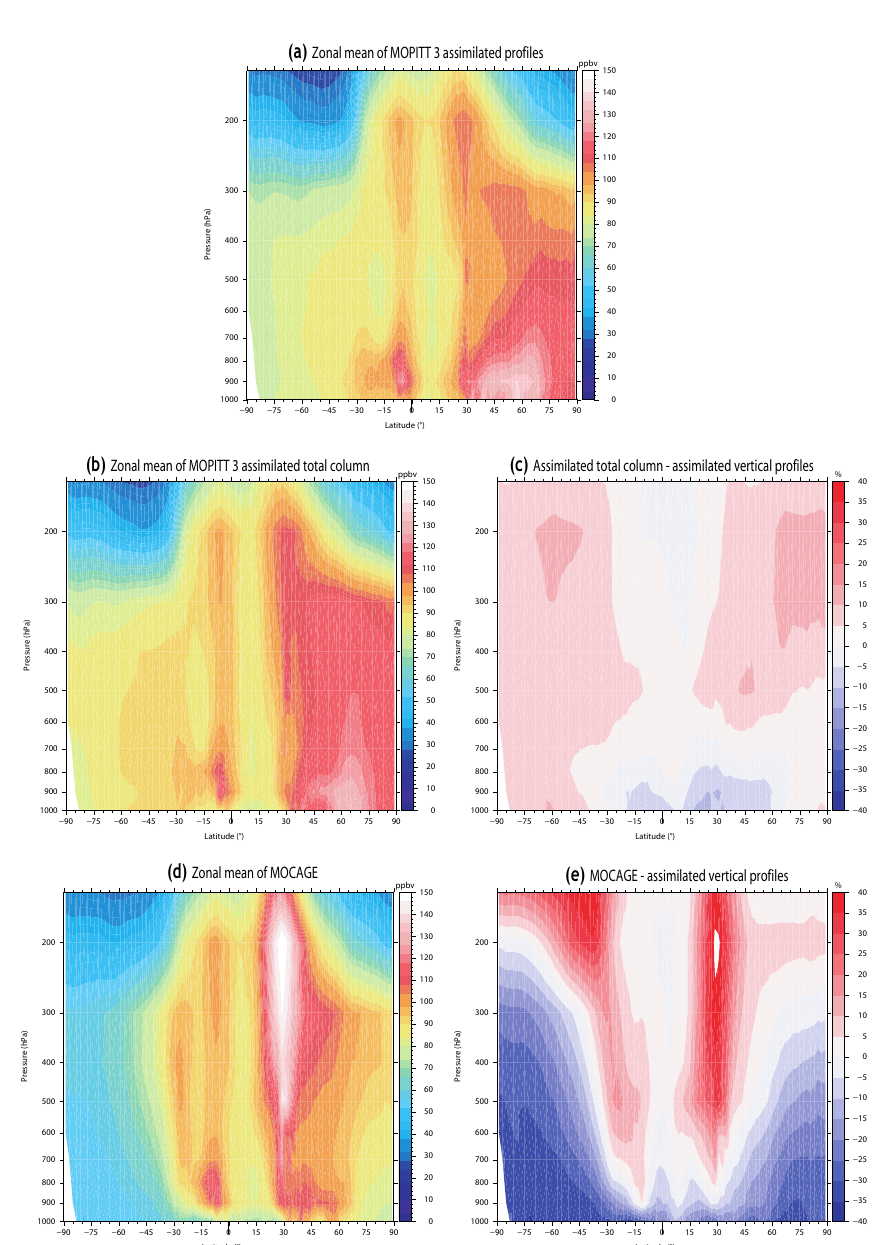
Figure 12. Zonal means of CO field for the month of August 2008 as obtained by (a) MOPITT PROFILE_ANALYSES taking into account Fig. 12. Zonal means of CO field for the month of August 2008 as obtained by: (a) : MOPITT PRO- averaging kernels and observation error covariance matrices, (b) MOPITT TOTCOL_ANALYSES, and (d) the MOCAGE free-run model. FILE ANALYSES taking into account averaging kernels and observation error covariance matrices ; (b) : The figures on the right present the difference in percent between TOTCOL_ANALYSES and PROFILE_ANALYSES (c) and the difference MOPITT TOTCOL ANALYSES ; and (d) : the MOCAGE free-run model. The figures in the right present the between the free-run model and PROFILE_ANALYSES (e) difference in % between TOTCOL ANALYSES and PROFILE ANALYSES (c) and the difference between the free-run model and PROFILE ANALYSES (e) .